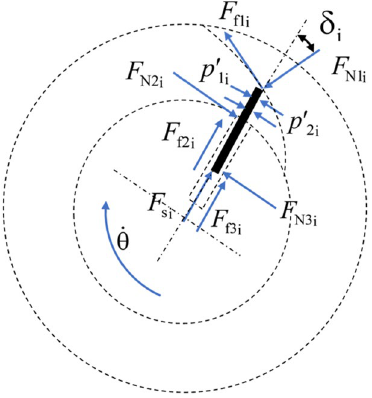
Figure 4. Schematic diagram of the motion of sliding vane i (Fig. 3 is drawn with the drawing tools of the Microsoft Word software and saved as a